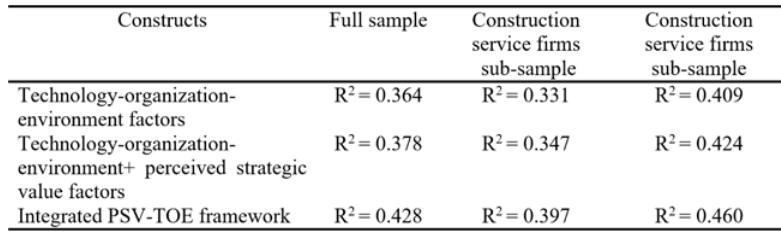
Sub-samples and full samples explanatory